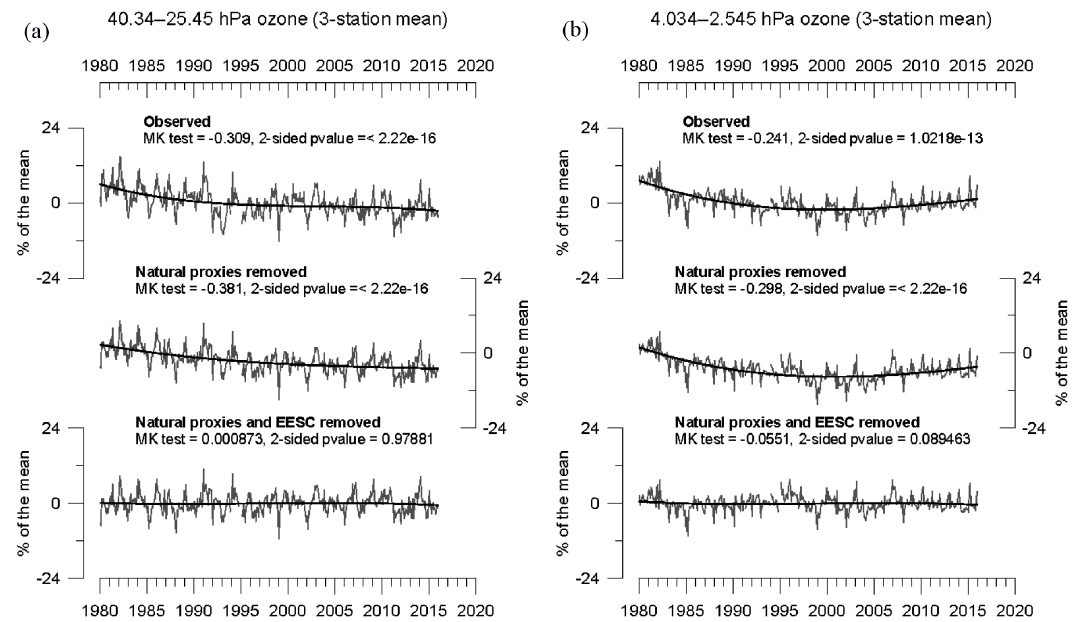
Figure 6. Ozone anomalies from SBUV overpasses averaged over Hohenpeißenberg, Haute Provence and Table Mountain. Top: original deseasonalized time series. Middle: time series with natural proxies removed, but EESC-related variations remaining. Bottom: time series with natural proxies and orthogonal EESC-related variations removed. (a) For layer 8 (40.34–25.45hPa, centred at about 24km height). (b) Same as in (a) but for the layer 13 (4.034–2.545hPa) centred at about 40km height. MK test refers to the Mann–Kendall trend test. Thick solid curves are third degree polynomials fit to the